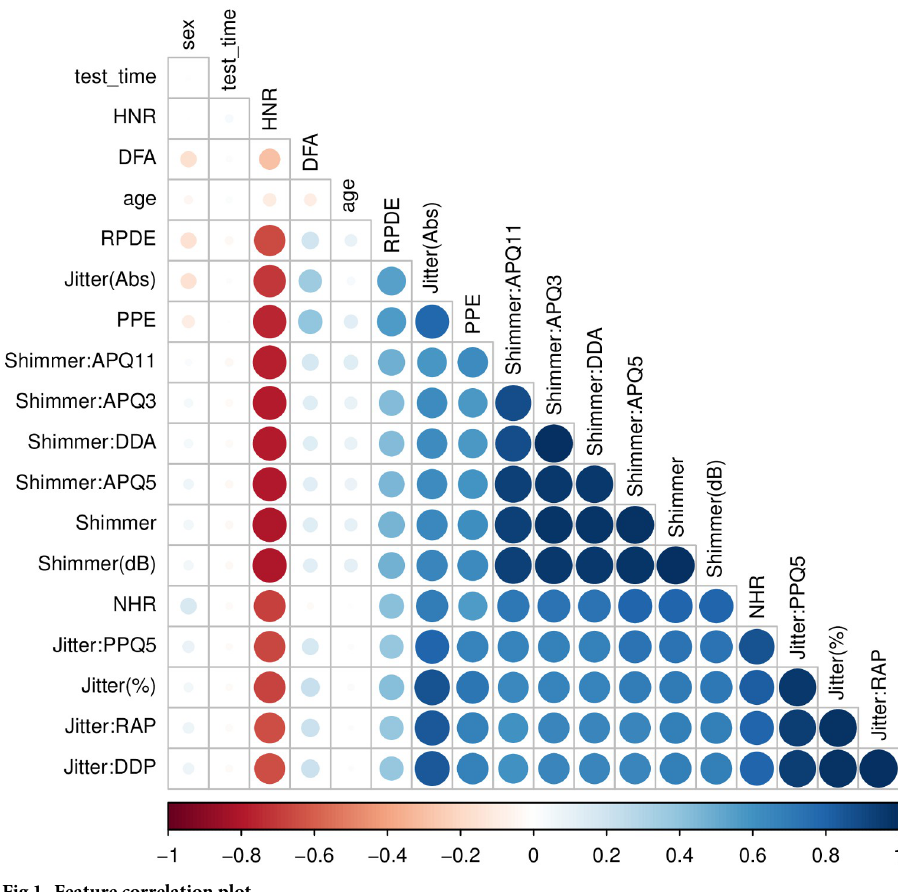
Fig 1. Feature correlation